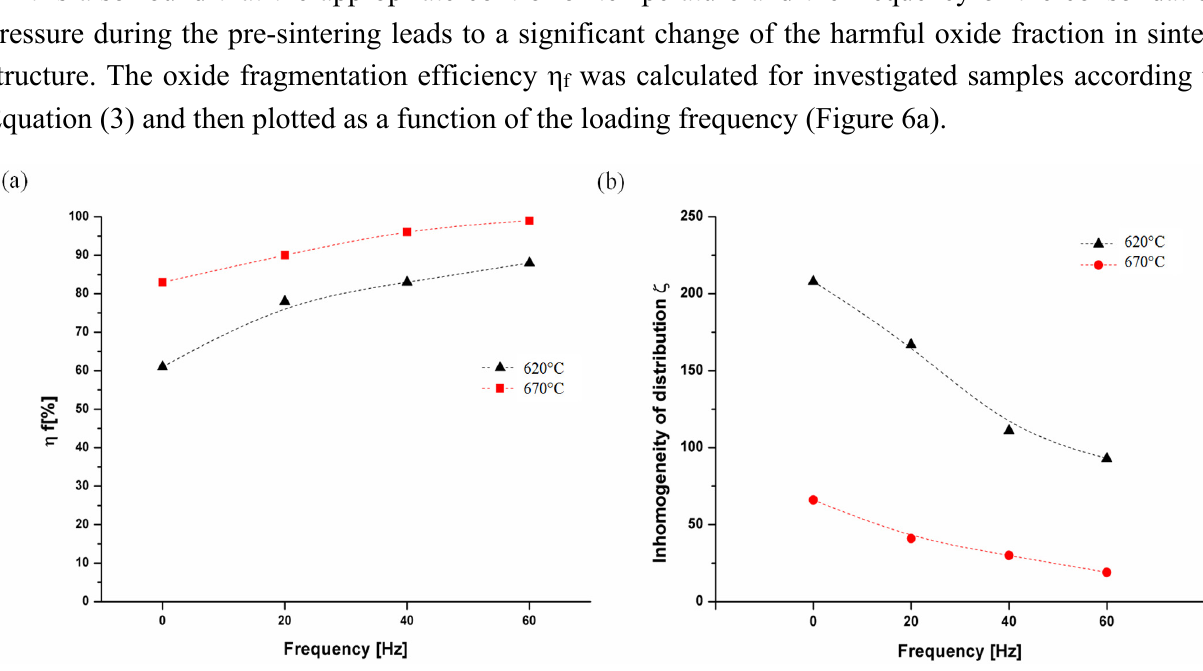
Figure 6. An influence of the loading frequency and the pre-sintering temperature on ( a ) Al 2 O 3 oxide fragmentation efficiency η f , ( b ) The inhomogeneity of oxide phase spacing ξ